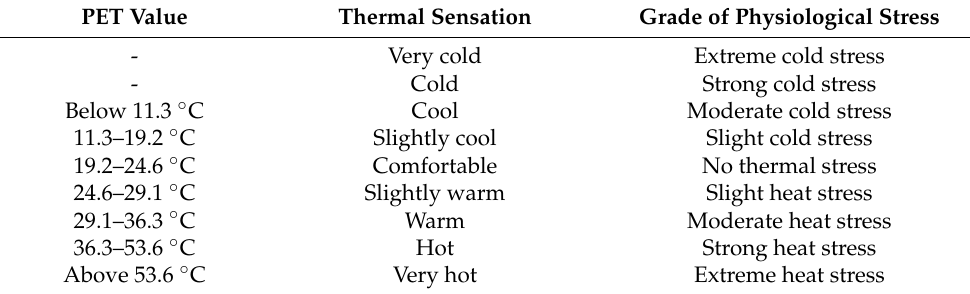
Table 6. Range for PET assessment in Guangzhou [67].